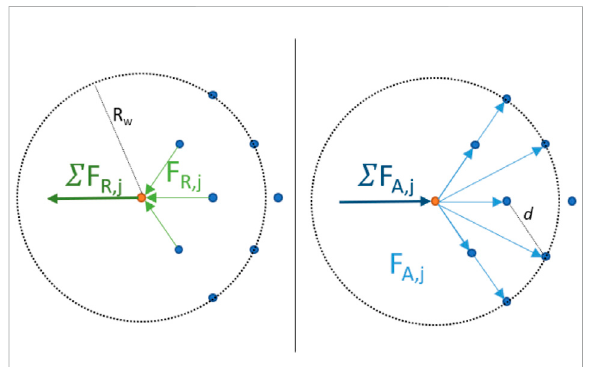
FIGURE 12 A simpli fi ed illustration of the forces acting on a robot R i (orange). F A , j corresponds to the attracting force due to neighbor j and F R , j to the corresponding repulsive force of neighbor j .